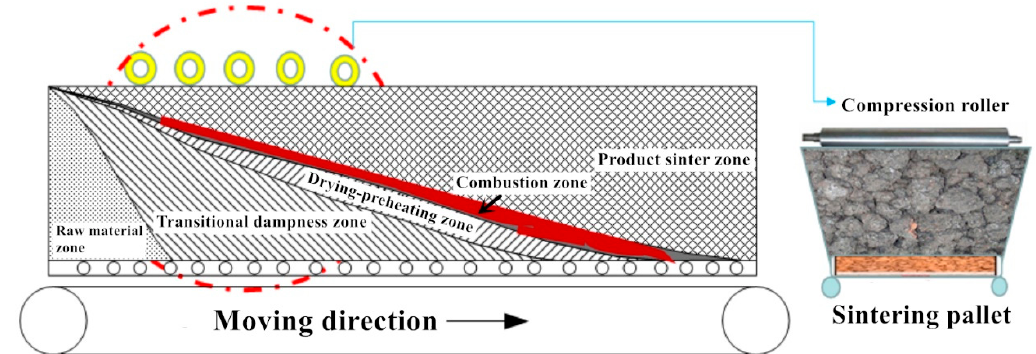
Figure 11. Schematic diagram of the pressurized densification sintering process in industrial applications. Table 7. Comparison of the sinter indices of limonitic laterite sintering in industrial production.